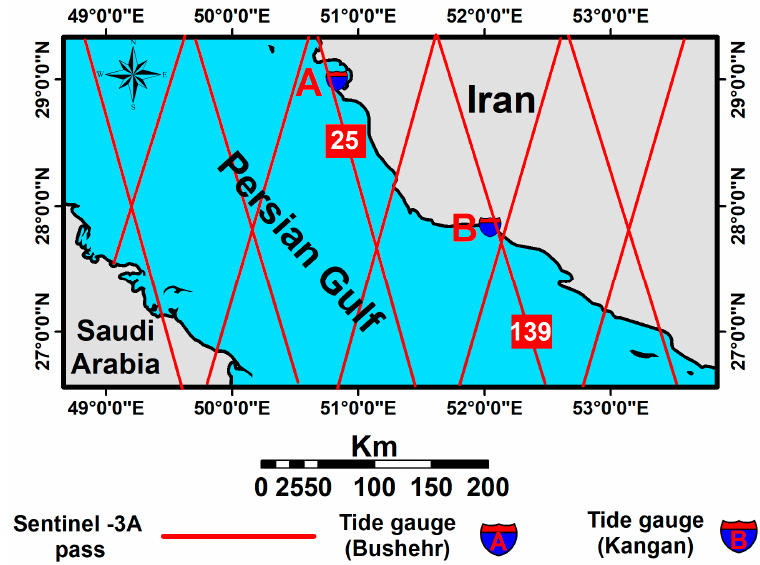
Figure 1. The location of the Sentinel-3A ground passes and tide gauge stations A (Bushehr) and B (Kangan) in the Persian Gulf.